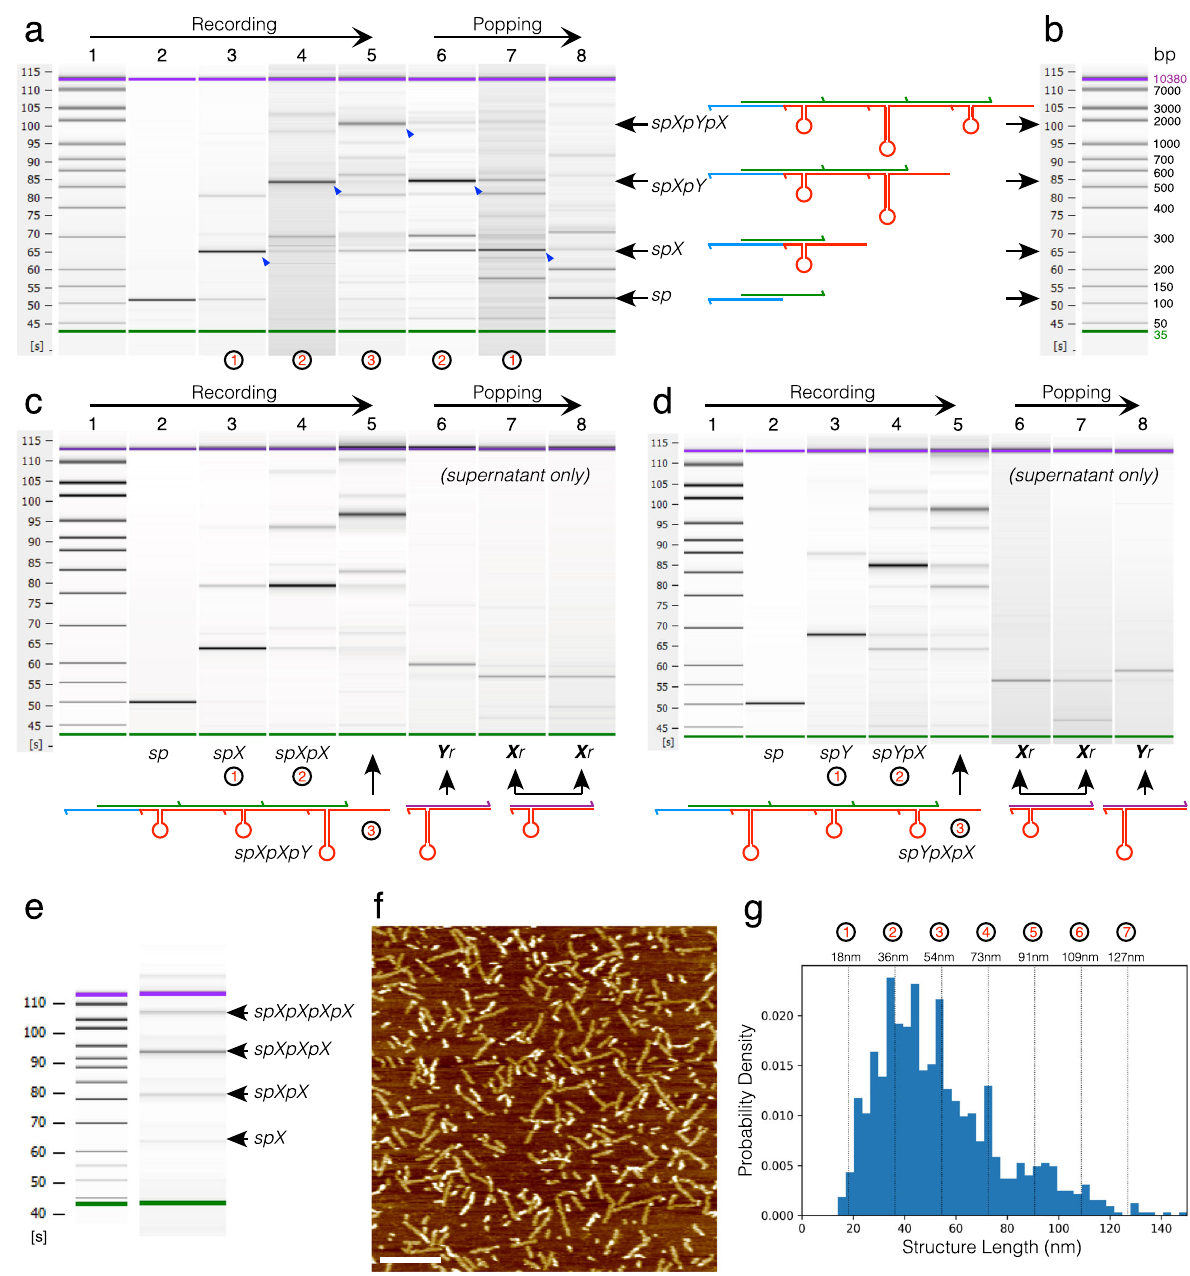
Fig. 4 Experimental results for a DNA stack operated with two signal types X and Y . a Capillary electrophoresis demonstrating elongation of stack complexes as signals X , Y , then X are recorded (lanes 2 – 5), followed by truncation of stack complexes during popping (lanes 6 – 8). Black circled numbers denote the target number of signals recorded in each lane. Blue arrows on virtual gel image denote migration band of target stack complex in each lane. b Conversion of capillary migration time ladder in seconds to approximate base pairs. c , d Recording signals on the stack data structure (lanes 2 – 5) and then analysis of only supernatant solution after read operations (lanes 6 – 8) revealing the double stranded signal complexes Xr and Yr popped off stacks. c X , X then Y is recorded, resulting in complexes Yr , Xr then Xr being popped into supernatant in reverse order. d Y , X then X is recorded, resulting in complexes Xr , Xr then Yr being popped. Lane reaction sequences in Supplementary Note 3.2. e Capillary electrophoresis of a stack sample where stacks are assembled with three X signals. f AFM micrograph of sample in e , scale bar 200 nm. g Distribution of stack assembly lengths on AFM micrograph (data from manual curation of 1022 objects in AFM fi eld) showing discrete peaks at lengths corresponding to 2 – 7 signals. See Supplementary Note 6 for AFM of recording XYX and XXY. All experiments were repeated independently three